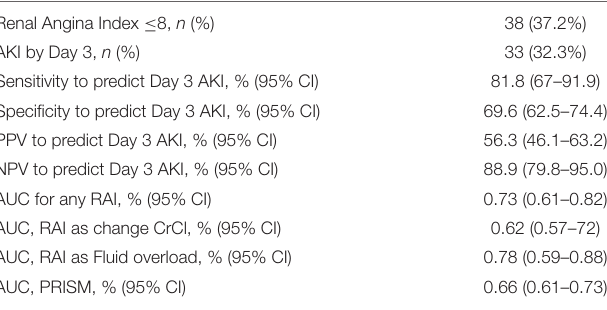
TABLE 6 | Independent association of peak FO with mortality.